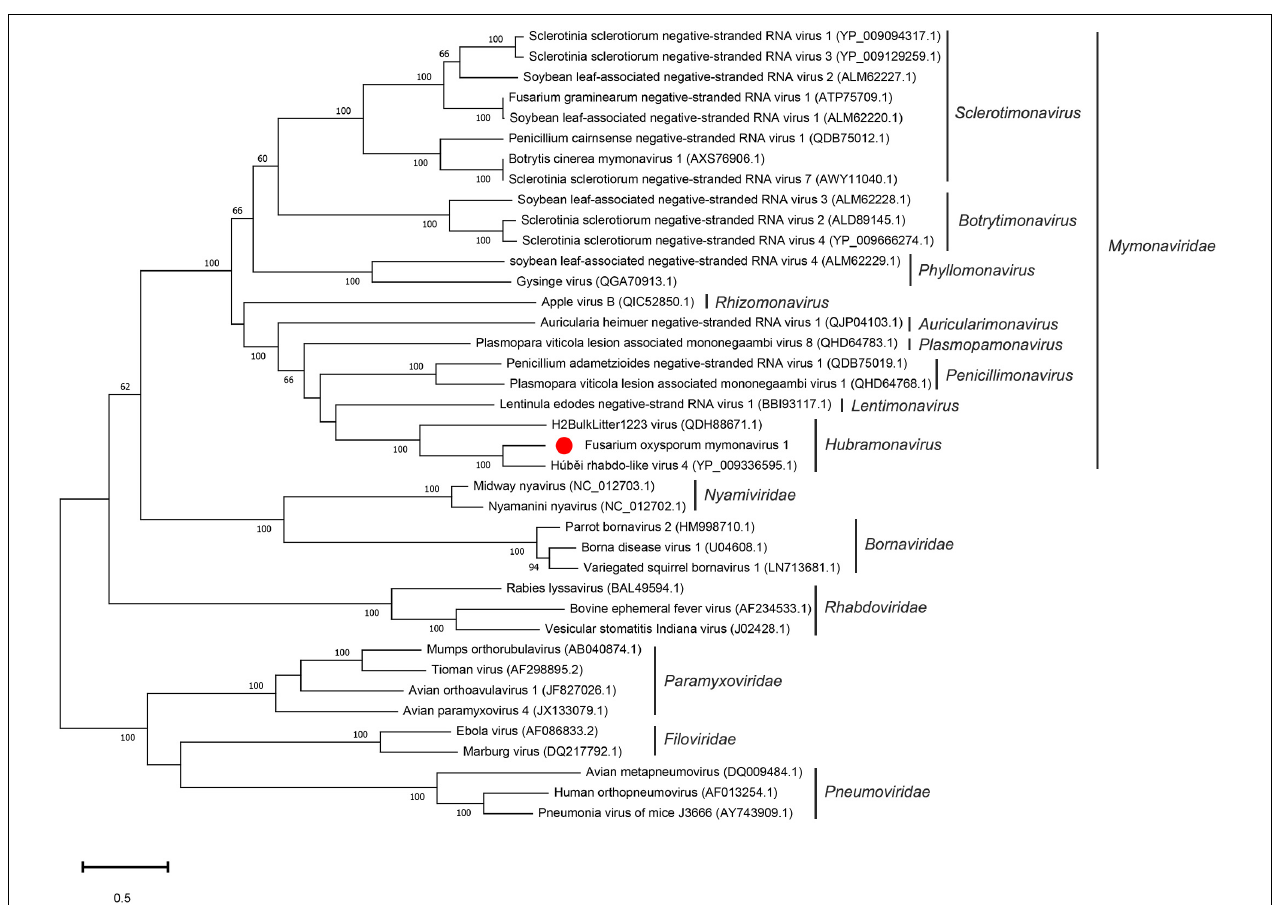
FIGURE 3 | Phylogenetic analysis of FoMyV1 (marked with a red dot) and other related (–)ss RNA viruses. The phylogenetic tree was generated by the maximum-likelihood method (1,000 bootstrap replicates) based on the amino acid sequences of the RdRp domains using